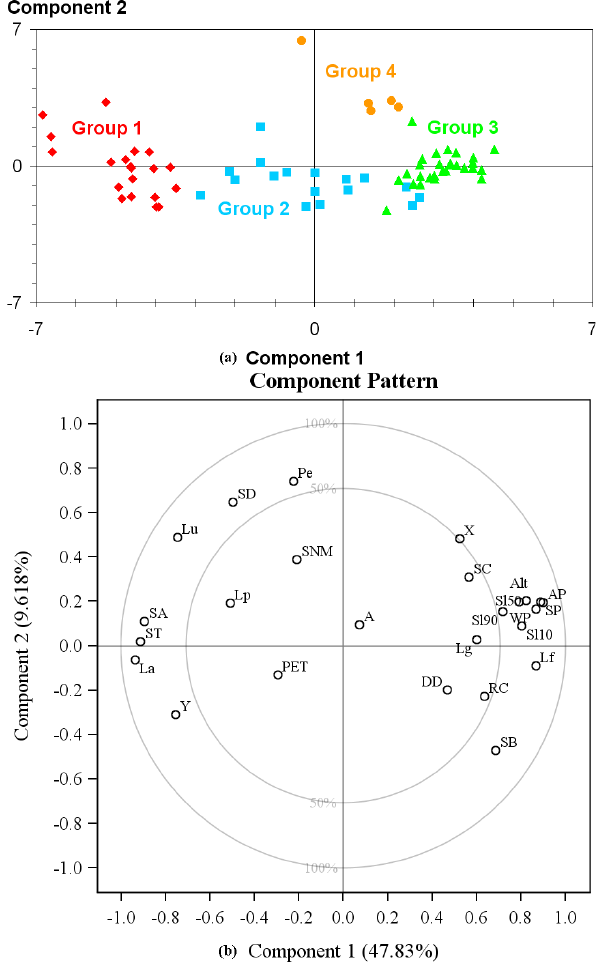
Fig. 3. Groups of catchments (a) and correlation circle (b) in the plane of the two first principal components. The two first compo- nents of the PCA allow distinguishing the four groups of catch-